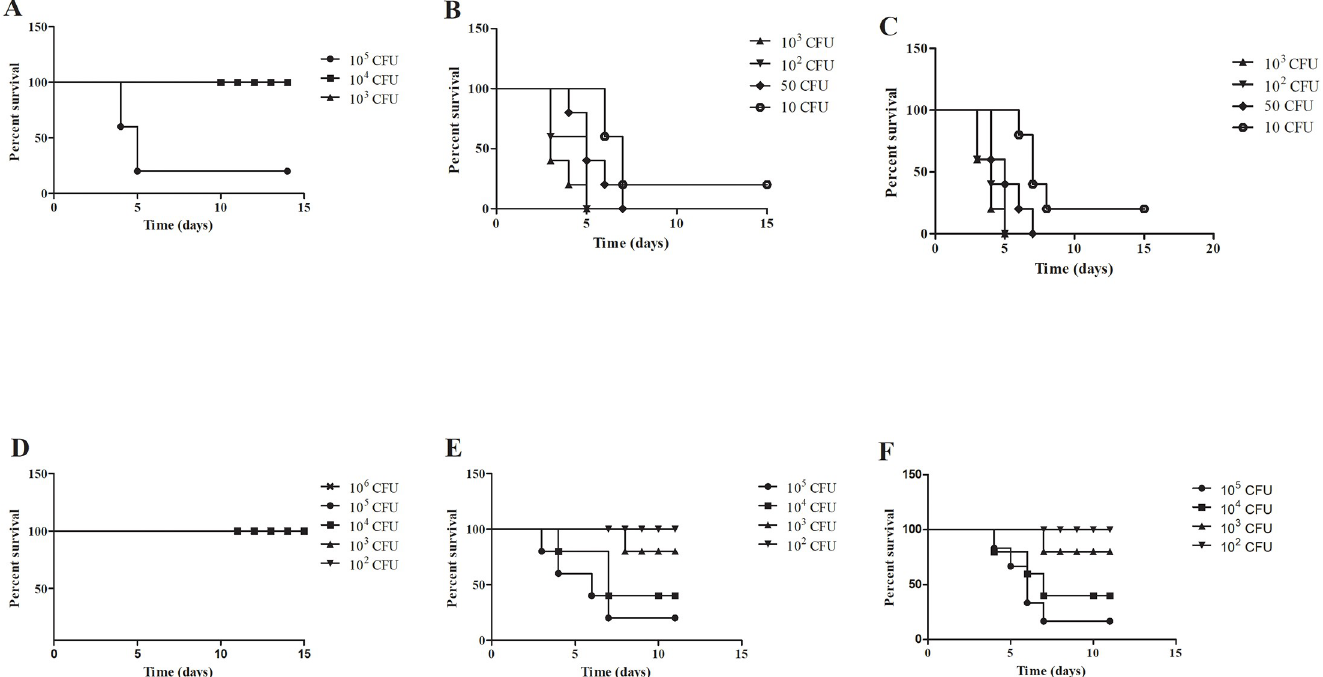
Fig 7. Survival of BALB/c mice infected with F . novicida . Groups of 5 mice were infected intratracheally (i.t.) with the pilO mutant strain (A) , wt F . novicida (B) , and the pilO / O complementant (C) . In addition, 5 mice per group were infected intradermally (i.d.) with the pilO mutant strain (D) , wt F . novicida (E) and the pilO / O complementant (F) . The infection doses are indicated in the figure legends. Infected animals were monitored for 15 days. The Prism GraphPad5 software was used to generate graphs as well as for the statistical analysis.